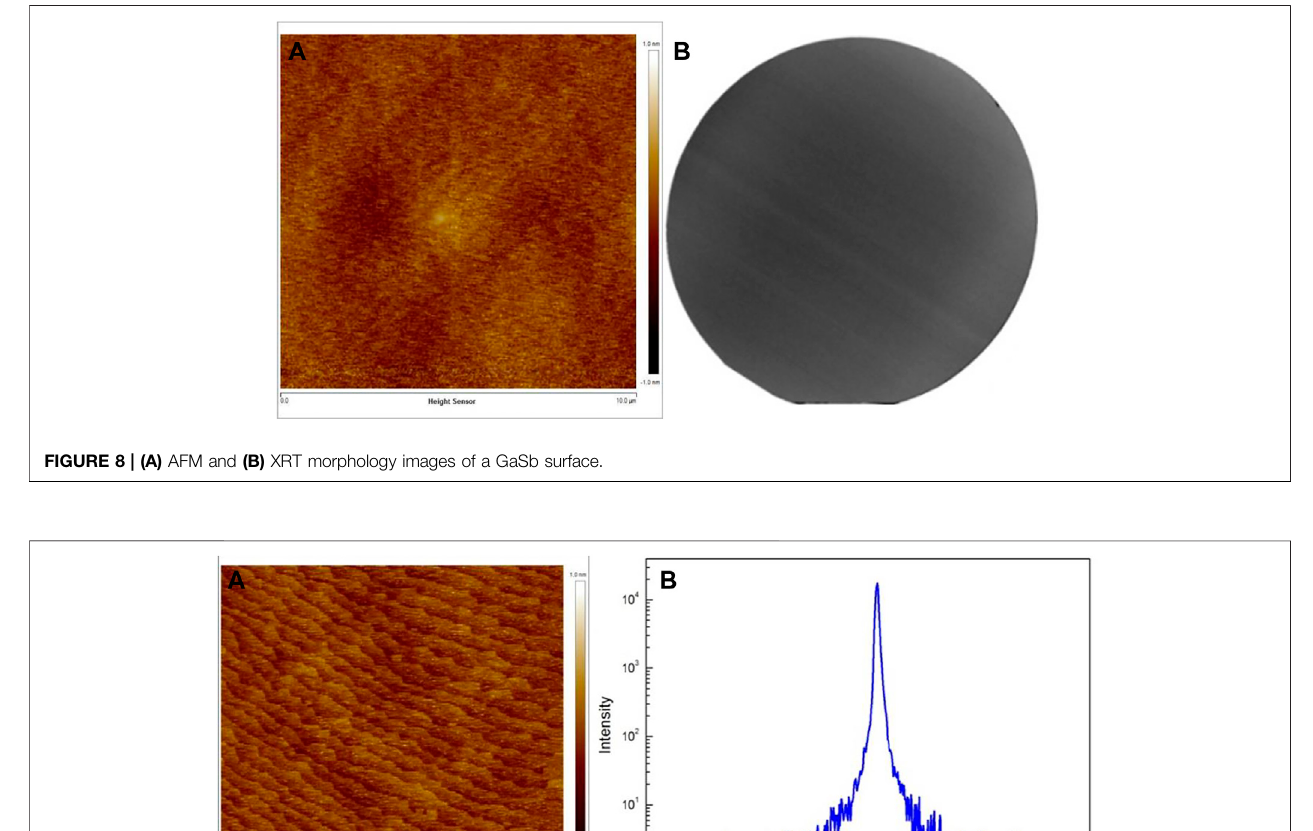
Frontiers in Materials |